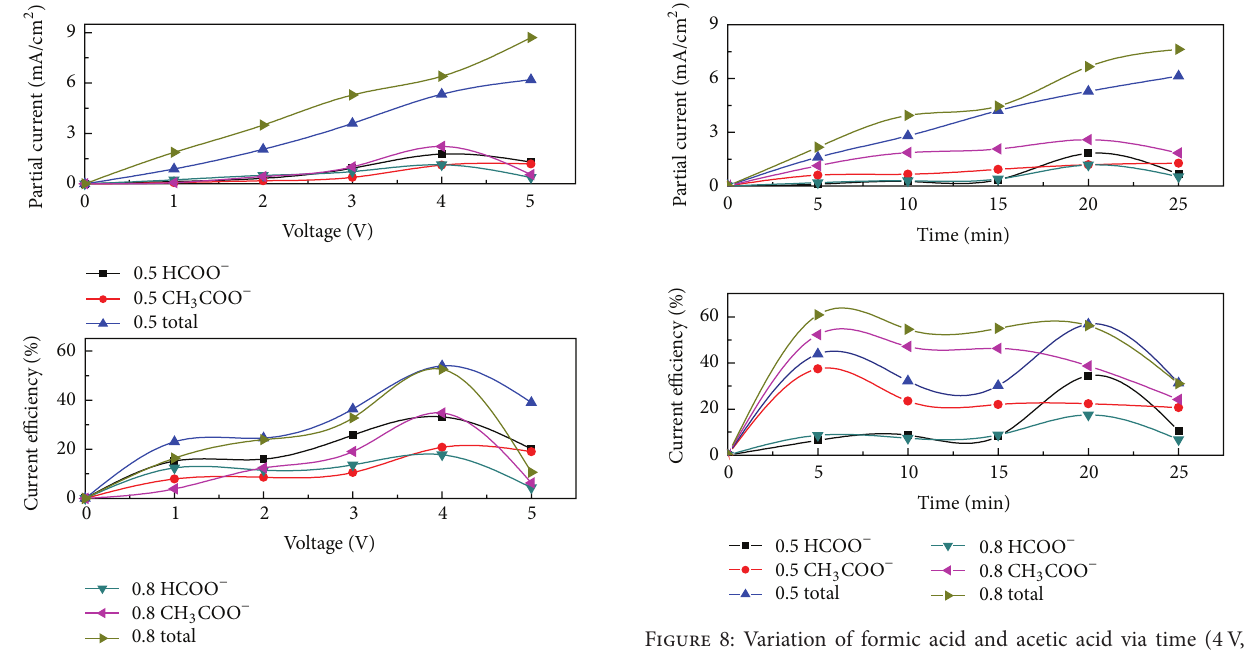
Figure 7: Correlation between the voltage, partial current density, and current efficiency of reduction products formed in the electro- chemical reduction in 0.5mol/L and 0.8mol/L KHCO 3 solutions (20min).